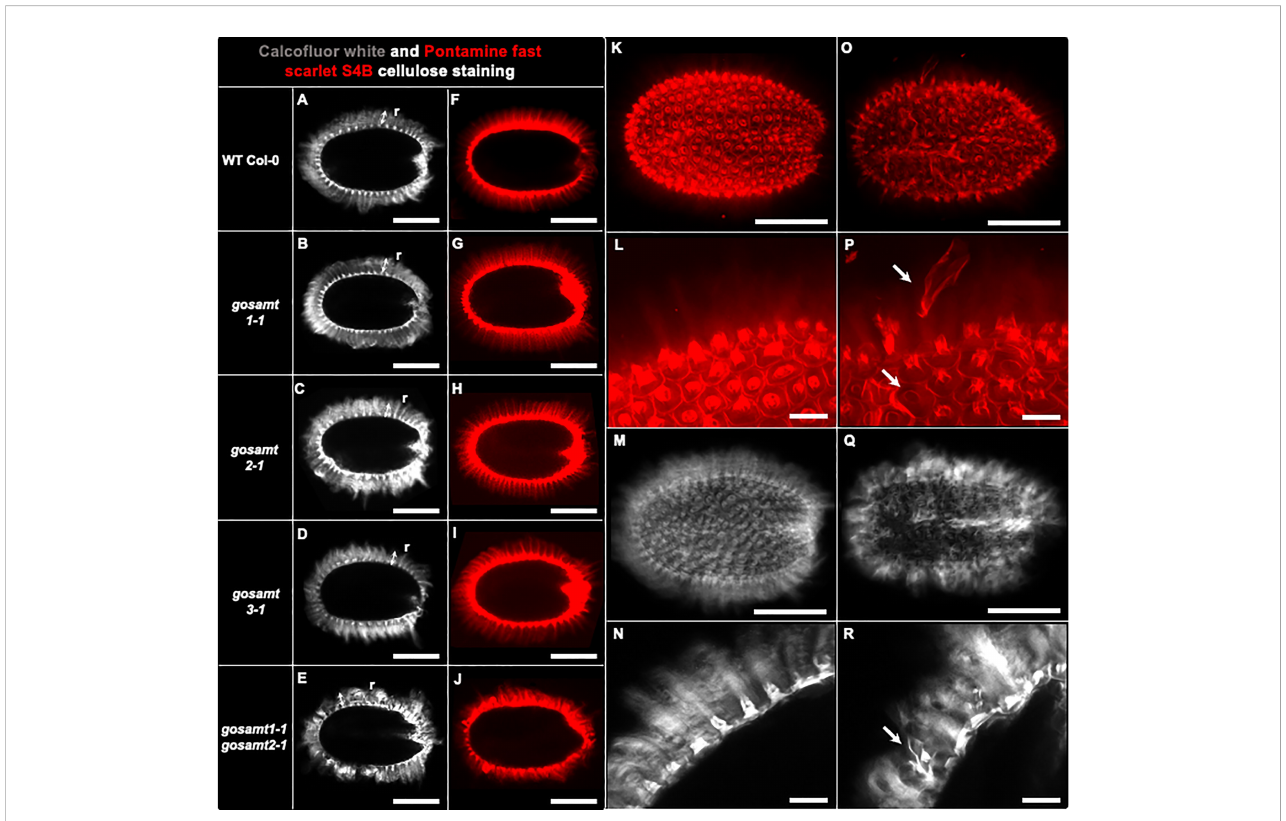
FIGURE 9 gosamt1-1gosamt2-1 seed coat epidermal cells exhibit an altered cellulose structure. Confocal microscopy optical sections of B-glycans staining in the inner layer of AM with Calco fl uor white (i.e., A – E, M, N, Q, R ) and Pontamine fast scarlet 4B (S4B) (i.e., F – L, O, P ). r, two headed arrow, cellulosic rays; white arrow in (P, R) show abnormal structure observed in gosamt1-1gosamt2-1 double mutant. Scale bars: (A – J) = 200 µm; (K, M, O, Q) = 200 µm; (L, N, P, R) = 50 m